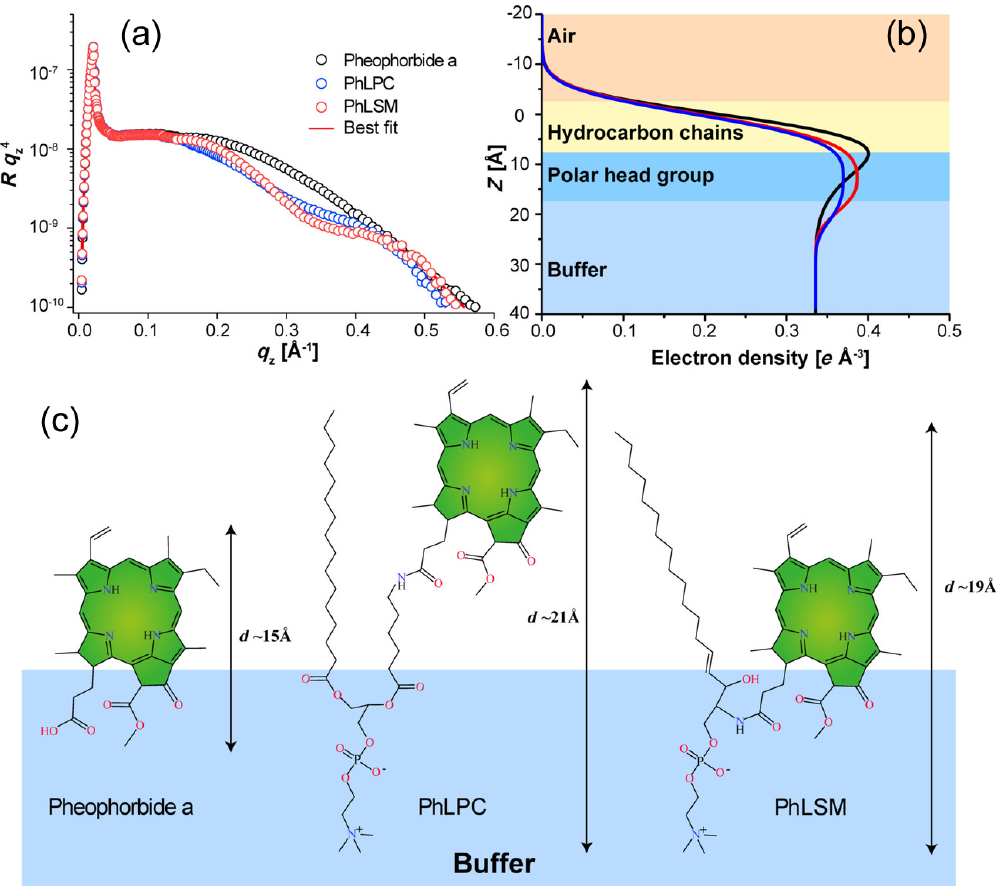
Figure 19. ( a ) XRR curves of monolayers of a Pheo-a derivatives at a surface pressure of 30 mN/m. The solid lines represent the best fit models to the experimental data. ( b ) The reconstructed electron density profiles along the z-axis. ( c ) Schematic representation of the orientation of Pheo-a derivatives at the air-buffer interface. Adapted from Massiot et al. [171] with permission from the John Wiley and Sons c Wiley (cid:13)